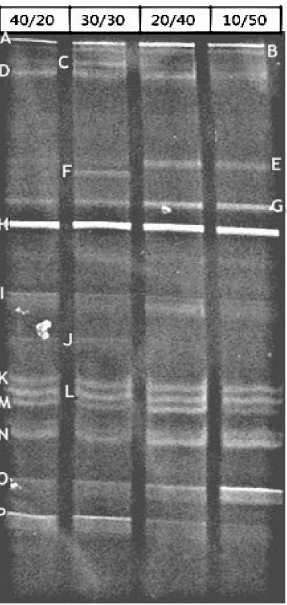
Figure 9. Denaturing gradient gel electrophoresis (DGGE) profiles of PCR-amplified 16S rDNA extracted from the sludge. The values of 40/20, 30/30, 20/40, and 10/50 figures on the top of the graph represent the aeration/non-aeration periods during intermittent aeration. Alphabetic bands were excised, purified, and re-amplified to determine their sequences. The gradient concentration of the denaturant used was